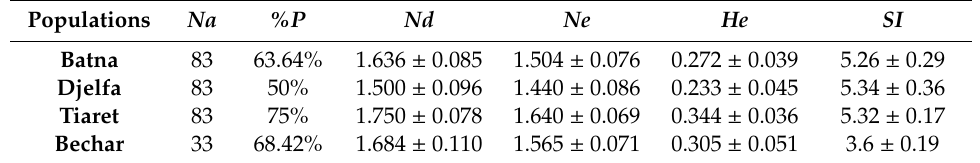
Table 2. Genetic diversity of the four populations of P. atlantica Desf. inferred by the two ISSR markers. Populations Na %P Nd Ne He SI Batna 83